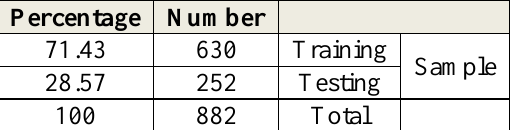
Table 5. Assignment of sample